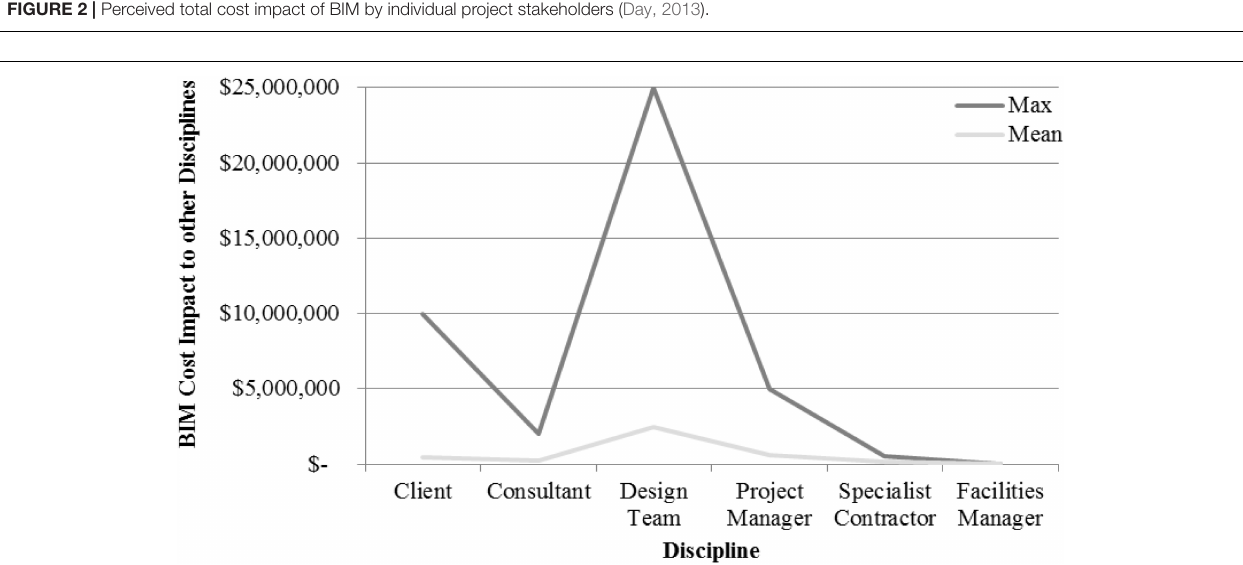
FIGURE 2 | Perceived total cost impact of BIM by individual project stakeholders (Day, 2013).